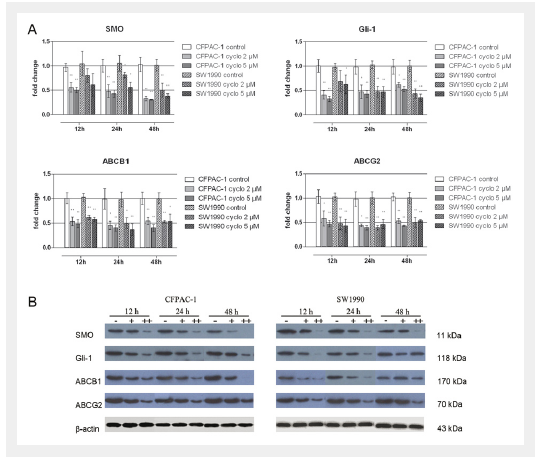
Effects of cyclopamine on the expression of SMO, Gli-1, ABCB1 and ABCG2 in gemcitabine-resistant pancreatic cell lines. A, Relative mRNA level changes were evaluated using quantitative RT-PCR, and the expression of β-actin was used as a control to normalise the relative expression of each gene before and after cyclopamine treatment. Fold change was analysed using the 2 – ΔΔ Ct method. Values are expressed as means ± SD. B, Changes in protein level before and after cyclopamine treatment were tracked by western blot assay. Treatment with 2 μM (+) and 5 μM (++) cyclopamine down-regulated protein levels of SMO, Gli-1, ABCB1 and ABCG2 in gemcitabine-resistant pancreatic cancer cell lines, compared with DMSO group (-). Membranes were reprobed with a β-actin antibody to verify equal loading and transfer. The molecular size markers (in kDa) are indicated on the right.